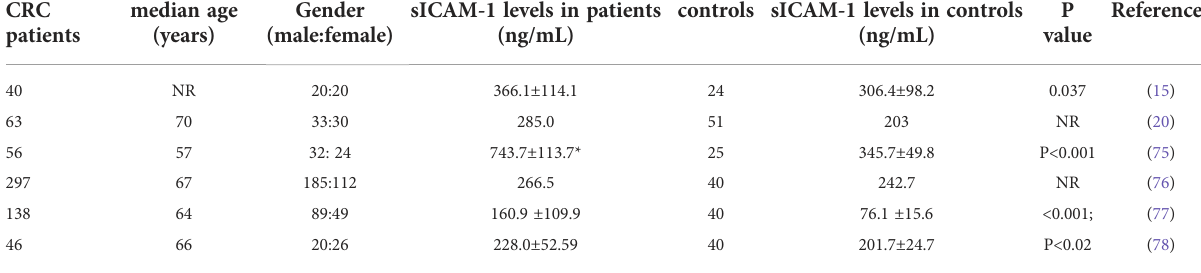
TABLE 1 Comparison of sICAM-1 levels between patients and controls. CRC